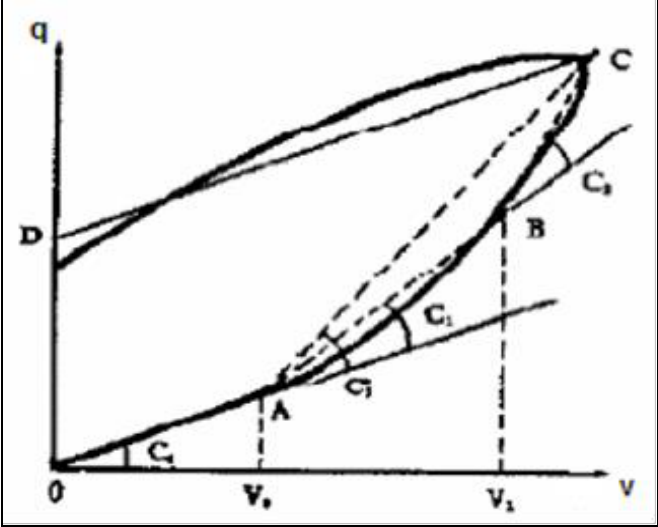
Figura 1: Curva v-q. Fuente: Los Autores, (2017).